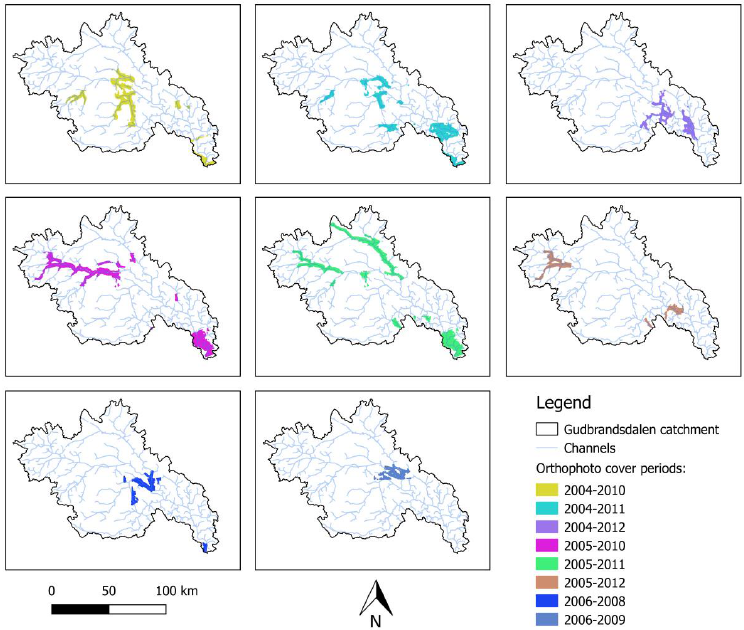
Figure 6. Time periods of the reference data used for the assessment of annual FCL. The productive forest areas of the catchment are covered by aerial imaging campaigns from different time periods. Each of the eight maps report the strata created based on the aerial image cover.